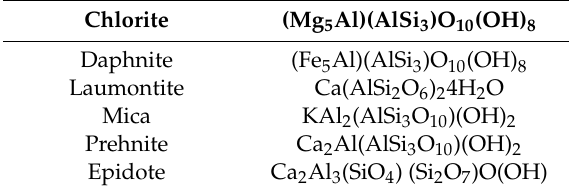
Table 1. Hydrous silicates commonly seen in deep granite fractures.